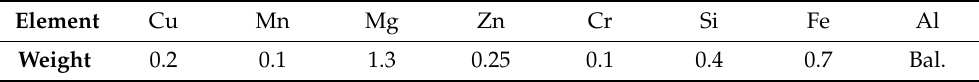
Table 1. Composition of Al–Mg alloy used in this study (wt. %).